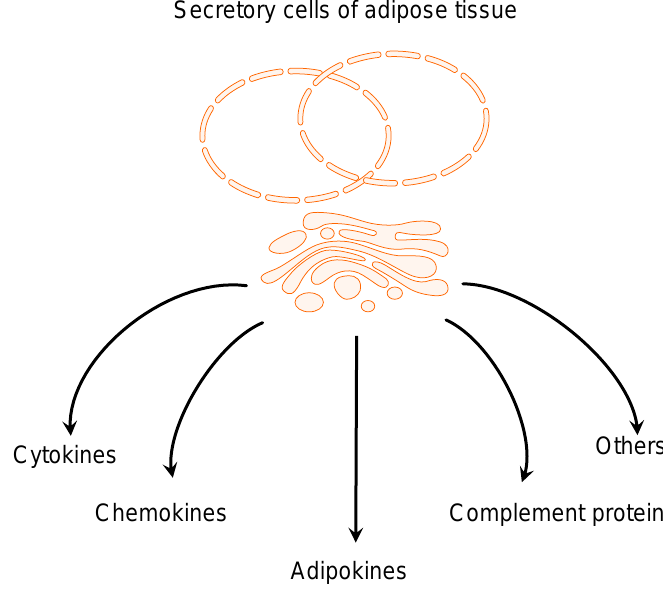
Figure 1. Adipose tissue secretome. Figure 1: Adipose tissue secretome